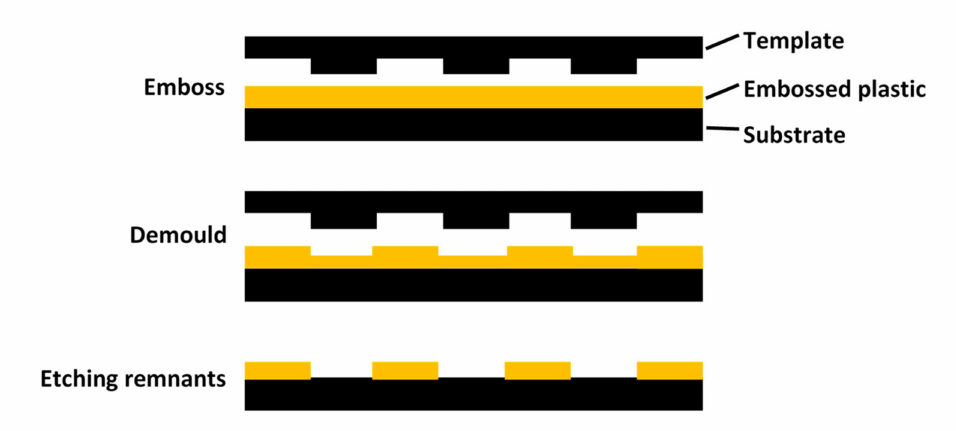
Figure 4. Flow chart of nanoimprint